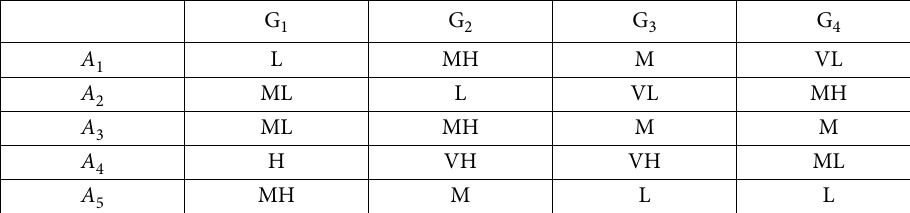
Table 2. Linguistic assessing matrix by first expert